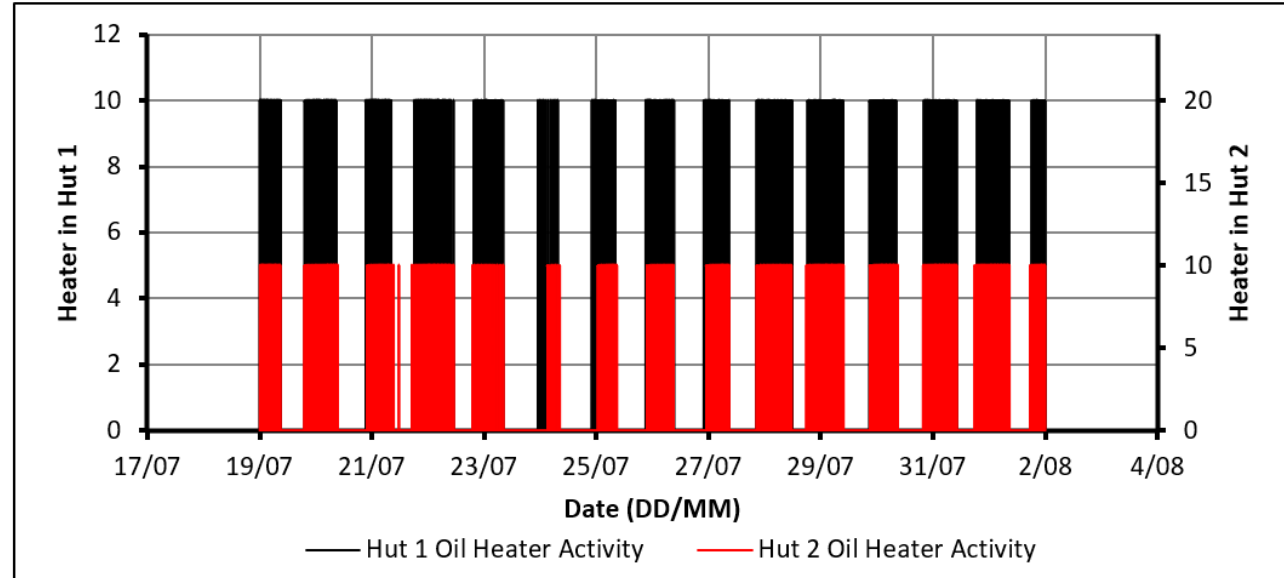
Figure 4. Activity of the oil heaters.